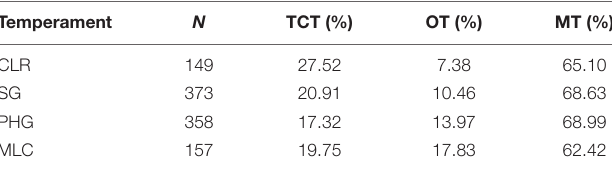
TABLE 4 | Comparison of teaching modes preferred by students of various temperament types.